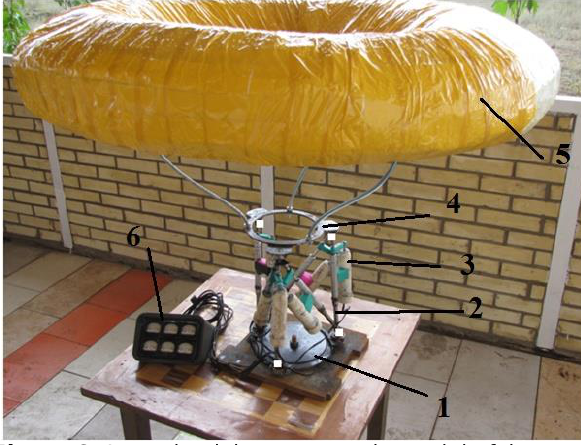
Figure 6. An acting laboratory-scale model of the